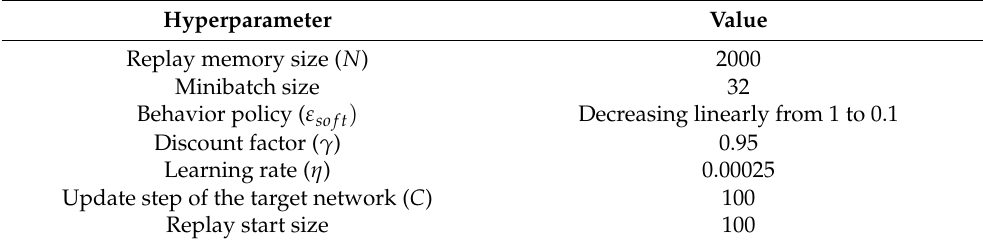
Table 3. List of hyperparameters and their values.